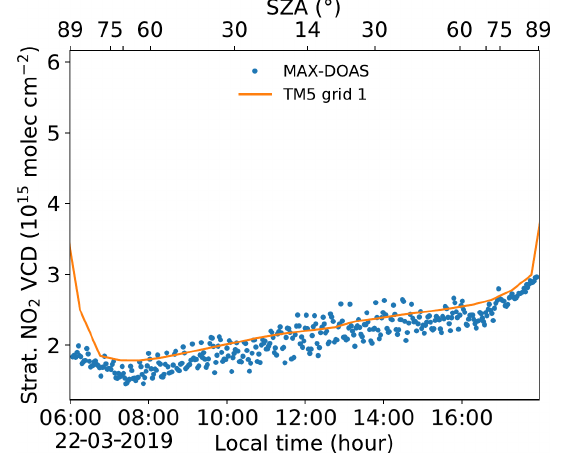
Figure 4. Stratospheric NO 2 vertical column densities on 22 March 2019, measured by MAX-DOAS and simulated by TM5. RV Sonne was stationary over the Pacific Ocean at 14.5 ◦ N, 125.5 ◦ W. TM5 simulations of one grid were used.